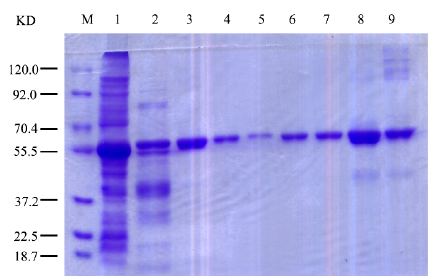
Figure 2. SDS ‐ PAGE of the r ‐ Ao FT and the site ‐ directed mutants. Lanes 1, crude cell extract; 2, the r ‐ Ao FT after nickel affinity chromatography; 3, the purified r ‐ Ao FT after Superdex ‐ 200 gel filtration chromatography; 4–9, the mutants D39A, D164A, E216A, N38L, S99A and Y282A after gel filtration chromatography. Table 1. Purification of the r ‐ AoFT from A. oryzae zz ‐ 01.